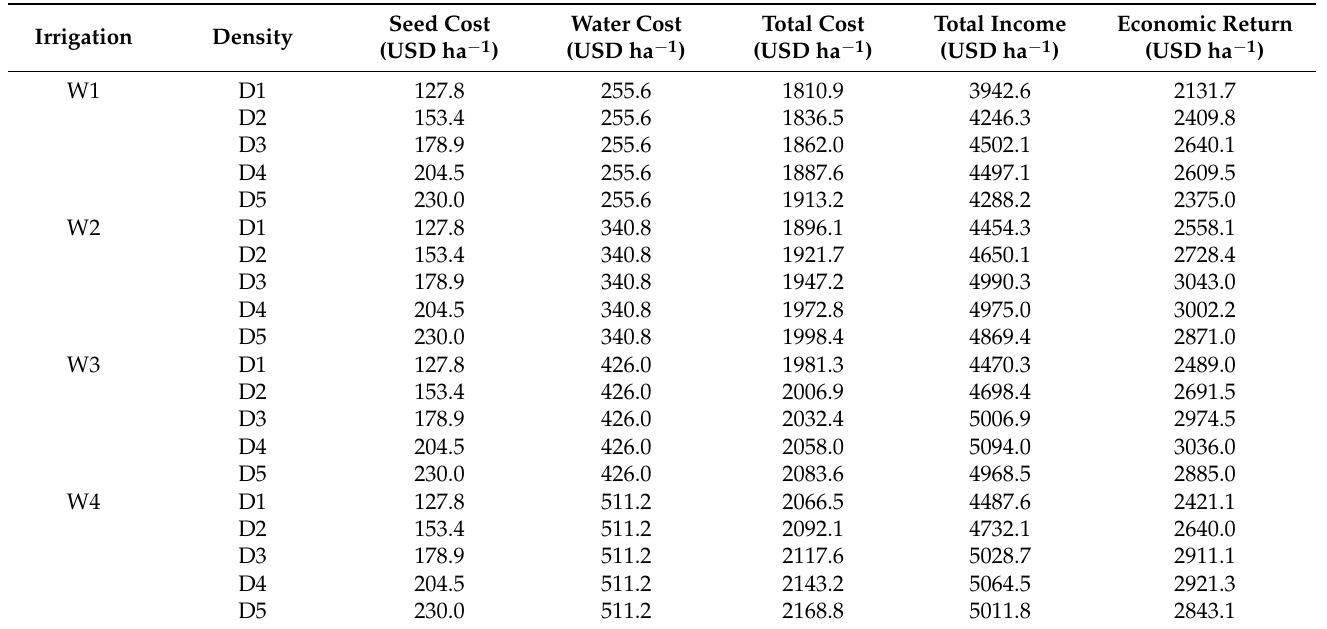
Table 3. Economic returns of maize under different irrigation and planting densities.